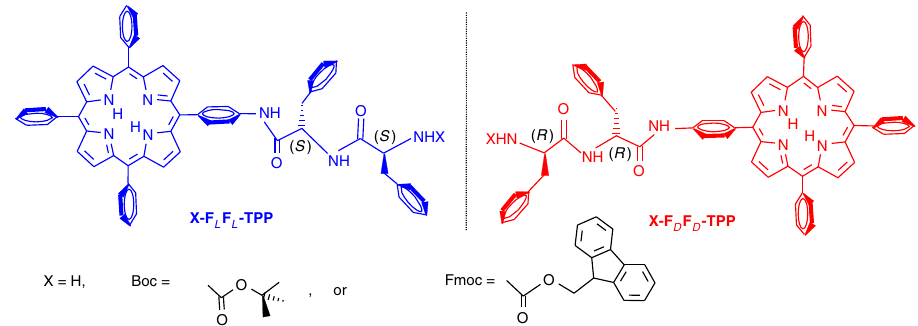
Figure 1 | Formulae of compounds addressed in this work. F L F L is the natural dipeptide while F D F D is its mirror image. In the unprotected version X ¼ H, while Boc stands for tert -butoxycarbonyl and Fmoc stands for 9-fluorenylmethoxycarbonyl.